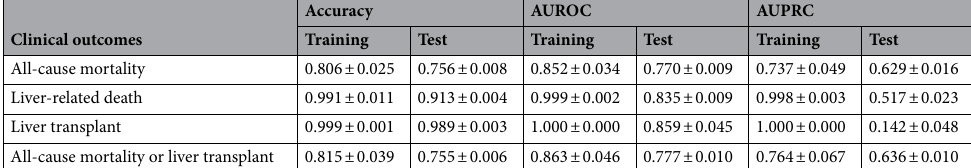
Table 5. Mean (± standard deviation) model performance measures in Training Set and Test Set across the nested fivefold cross-validation with 100 repetitions in patients with any liver disease (N = 11,583). AUROC = area under the receiver operating characteristic, AUPRC = area under the precision-recall